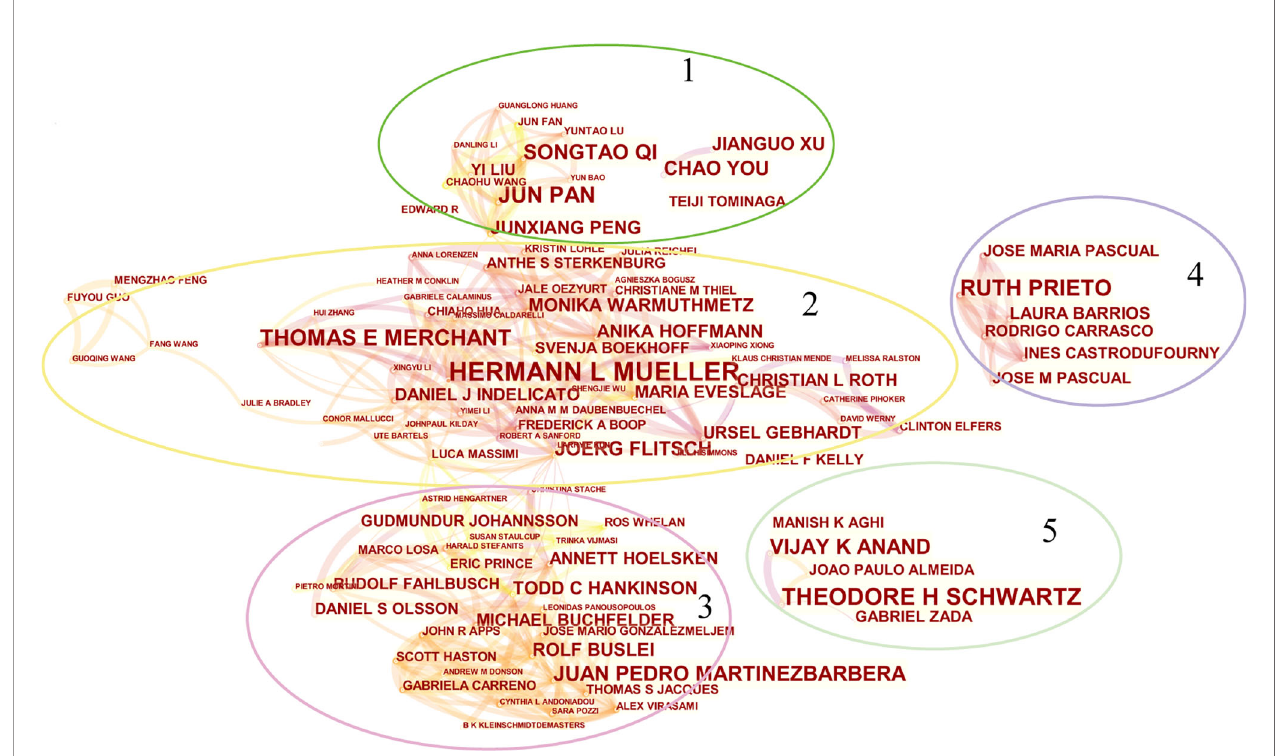
FIGURE 4 | The network map of productive authors. Conducted by CiteSpace (version 5.7.R3, Drexel